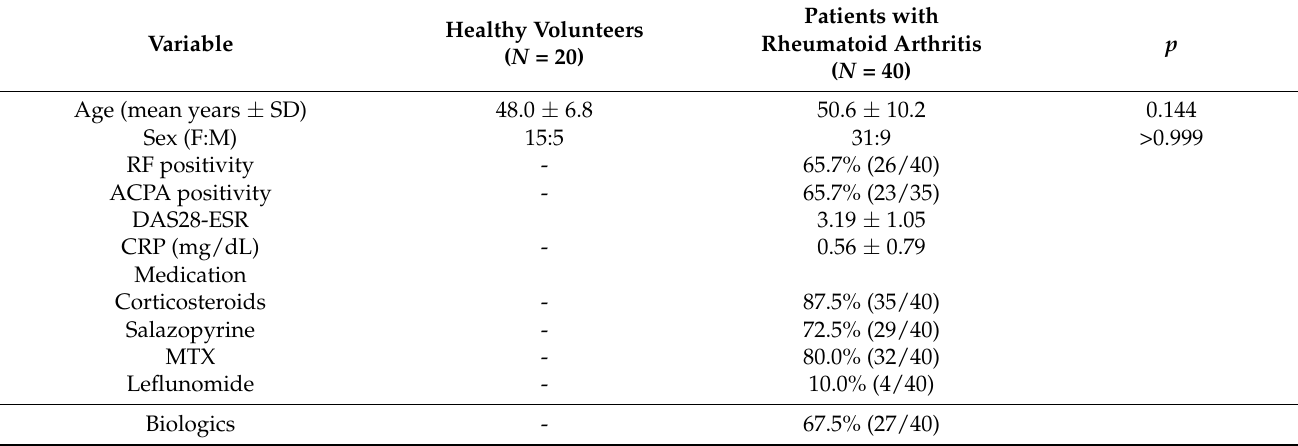
Table 2. Comparison of demographics and clinical data between patients with rheumatoid arthritis and healthy volunteers.